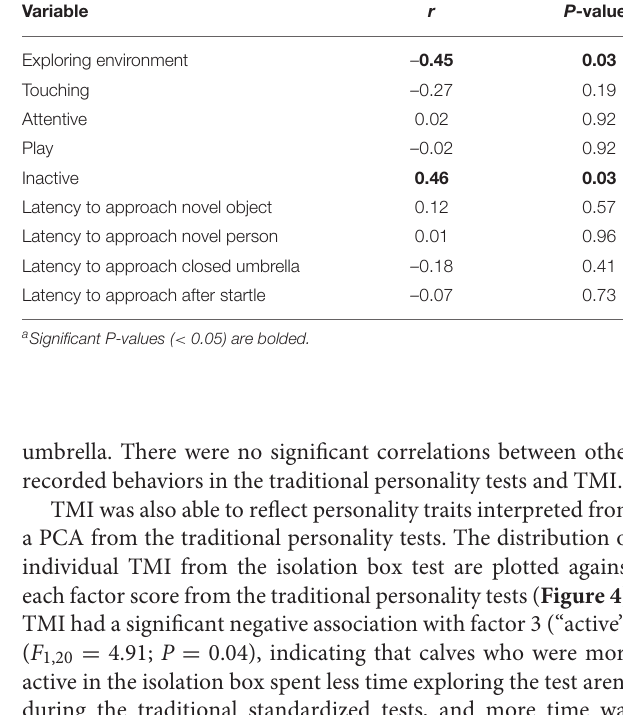
TMI and factor 1 (“fearful”) ( F 1,20 = 0.37; P = 0.55), or factor 2 (“bold”) ( F 1,20 = 1.49; P =